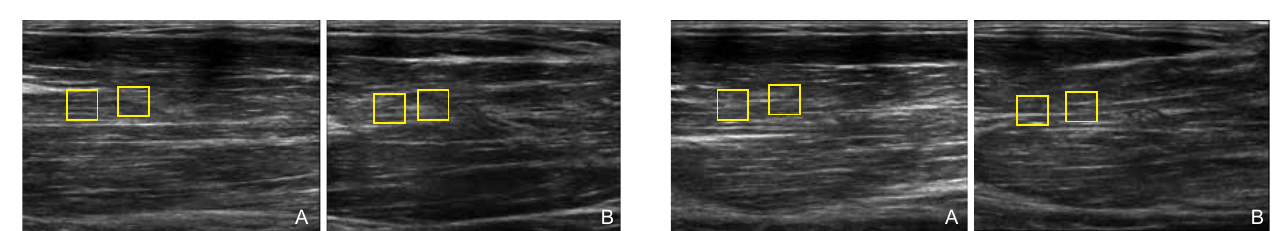
NOB, number of blobs of texture density; HOD, homogeneity of distribution of texture uniformity; IRGL, irregularity of texture primitive shape; SOB, mean size of blobs of texture primitive; DOD, directionality of texture distribution; POD, periodicity of texture distribution; Mean, Mean of texture gray scale; SDev, standard variance of gray scale.